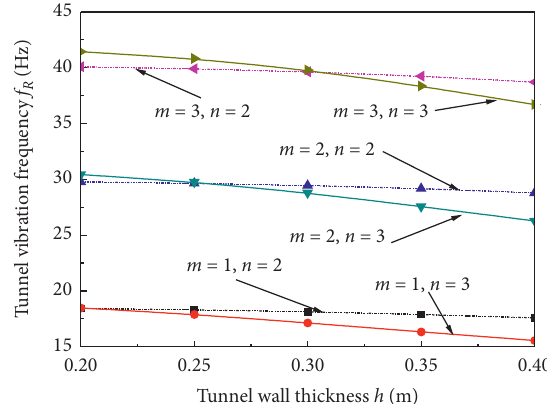
Figure 4: Relationship between natural frequency of the tunnel and changes in the tunnel radius change for different modes, where η � 1.0 × 10 6 Pa · s.